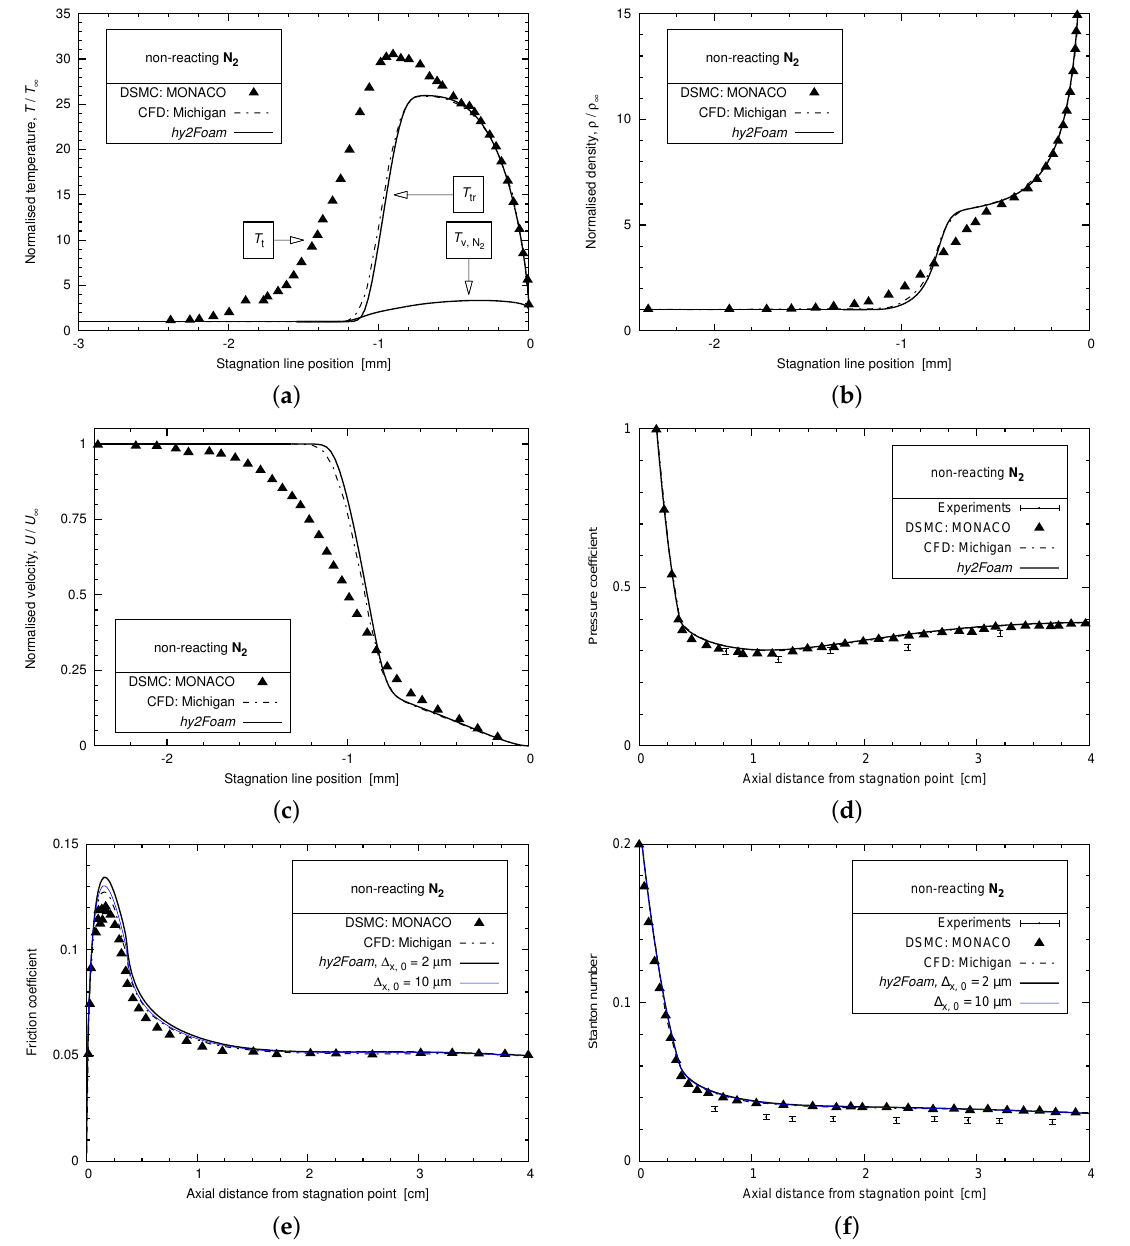
Figure 2. ( a – c ) Stagnation line profiles, and ( d – f ) surface quantities along the blunted cone; ( a ) normalised temperature; ( b ) normalised mass density; ( c ) normalised velocity; ( d ) pressure coefficient; ( e ) friction coefficient; ( f ) Stanton